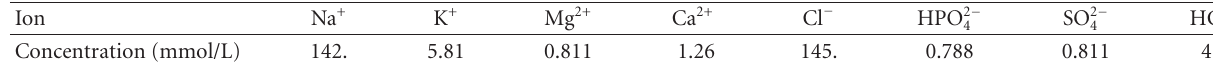
Table 1: Inorganic ion concentrations in the HBS solution.